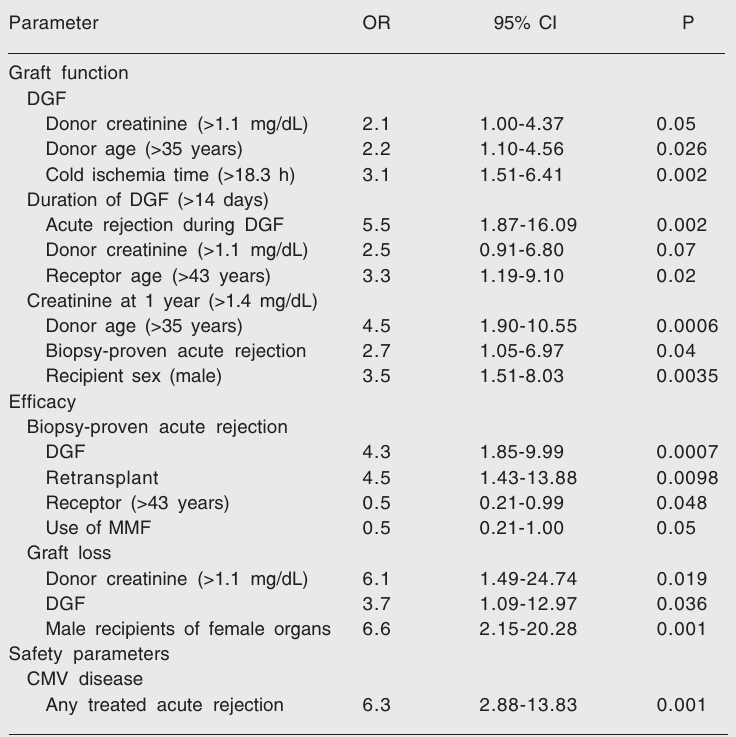
Table 5. Risk factors associated with graft function, efficacy and safety